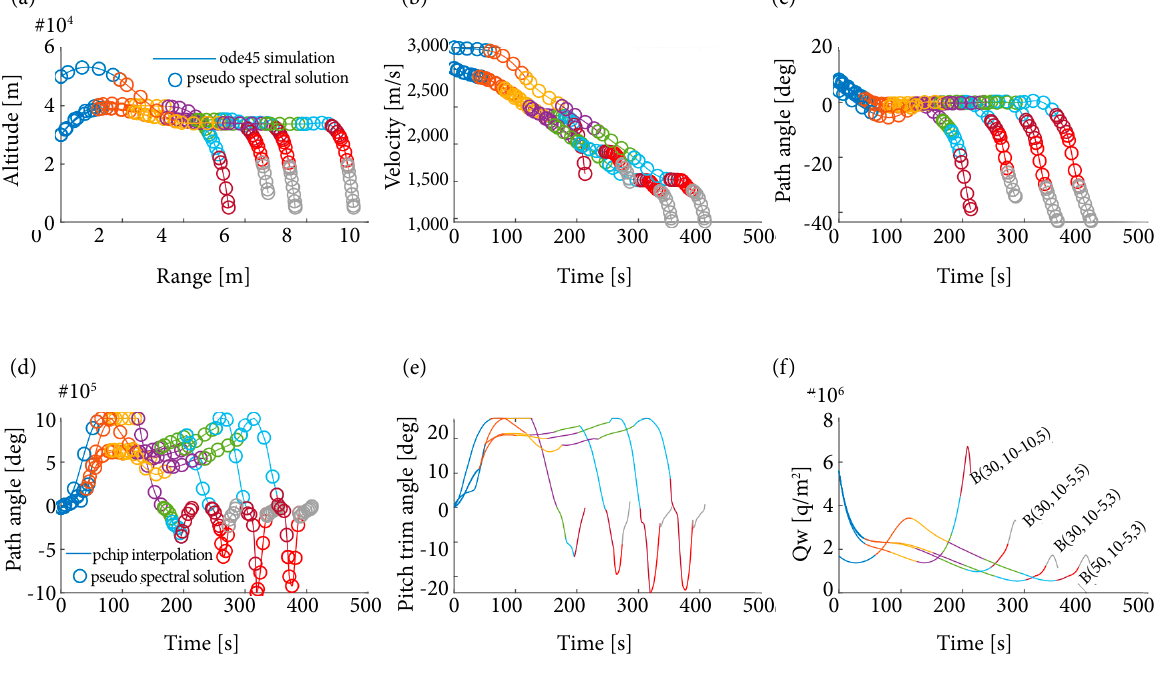
Figure 12. The trajectories under different two-point boundaries without heating